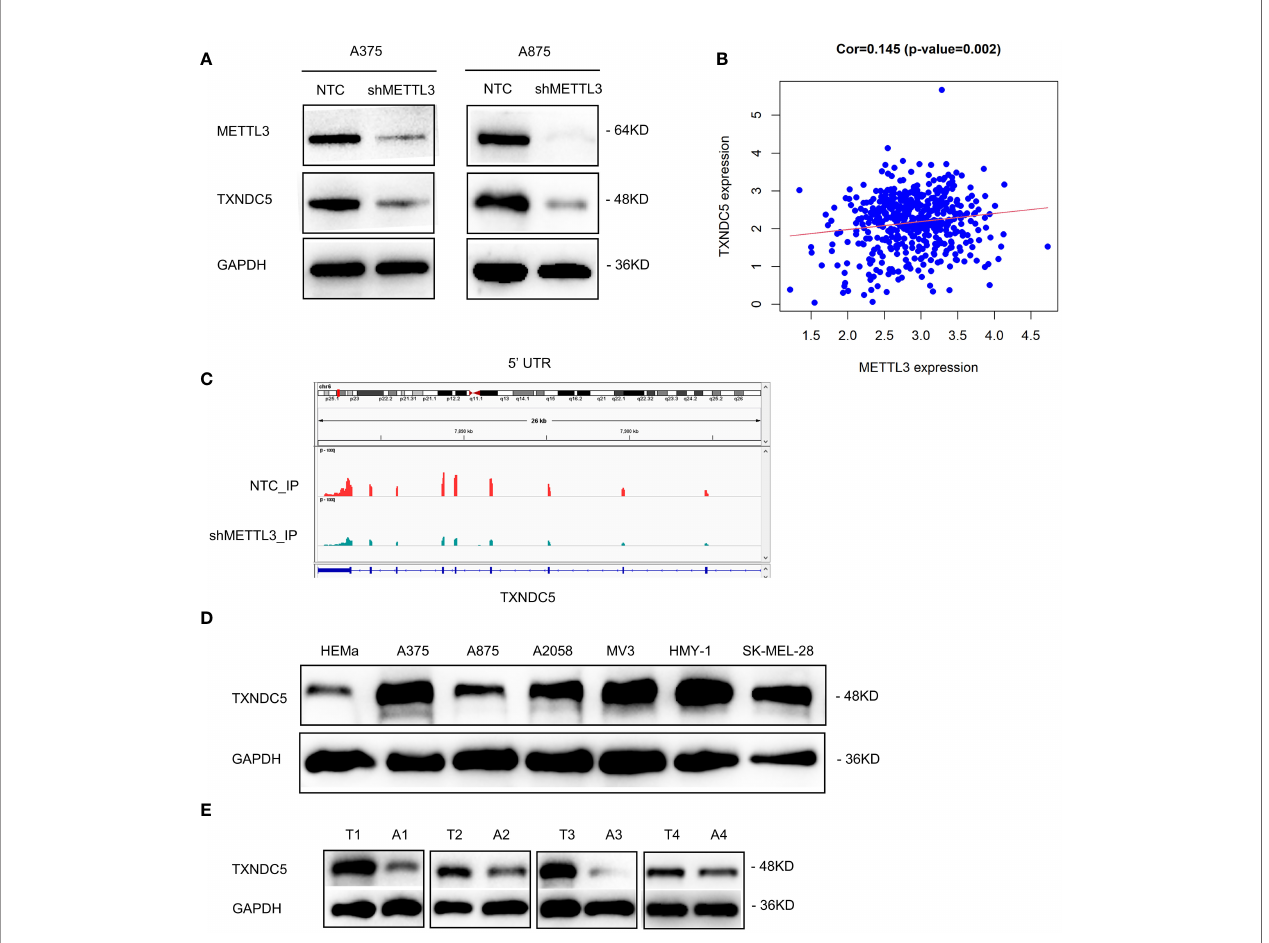
FIGURE 7 | METTL3 targeted TXNDC5 in melanoma regulation. (A) METTL3 knockdown downregulated the protein level of TXNDC5. (B) METTL3 expression was positively correlated with TXNDC5 expression in melanoma in TCGA. (C) database.m 6 A abundance on TXNDC5 mRNA was plotted by the IGV. METTL3 knockdown diminishes m 6 A modi fi cation of TXNDC5 mRNA in A375 cells. (D, E) TXNDC5 was signi fi cantly upregulated in melanoma cell lines and